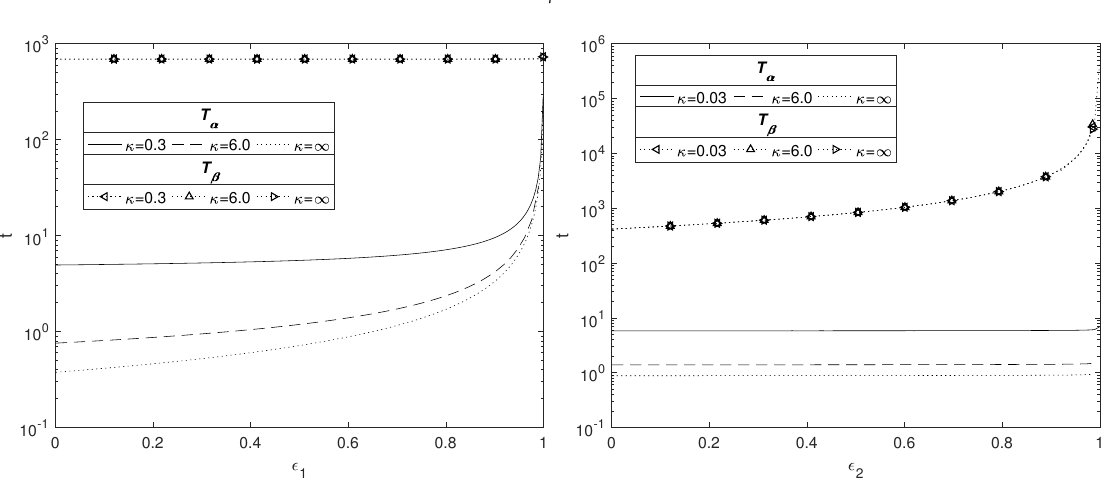
Figure 6. Plots of the dimensionsionless T α and T β against ε 1 ( left ) and ε 2 ( right ) for κ = 0.03,6 and κ → ∞ , with the remaining parameters listed in Table 4 and S 0 = 1.